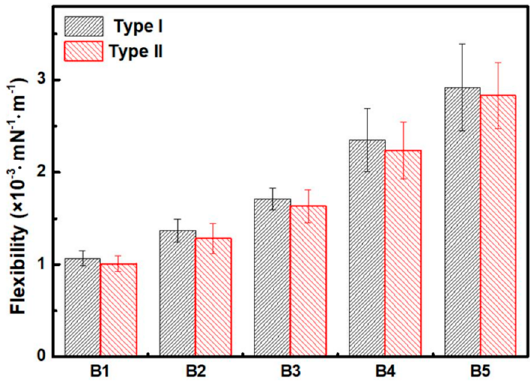
Figure 8. Flexibility of the same sample under different loading Types.